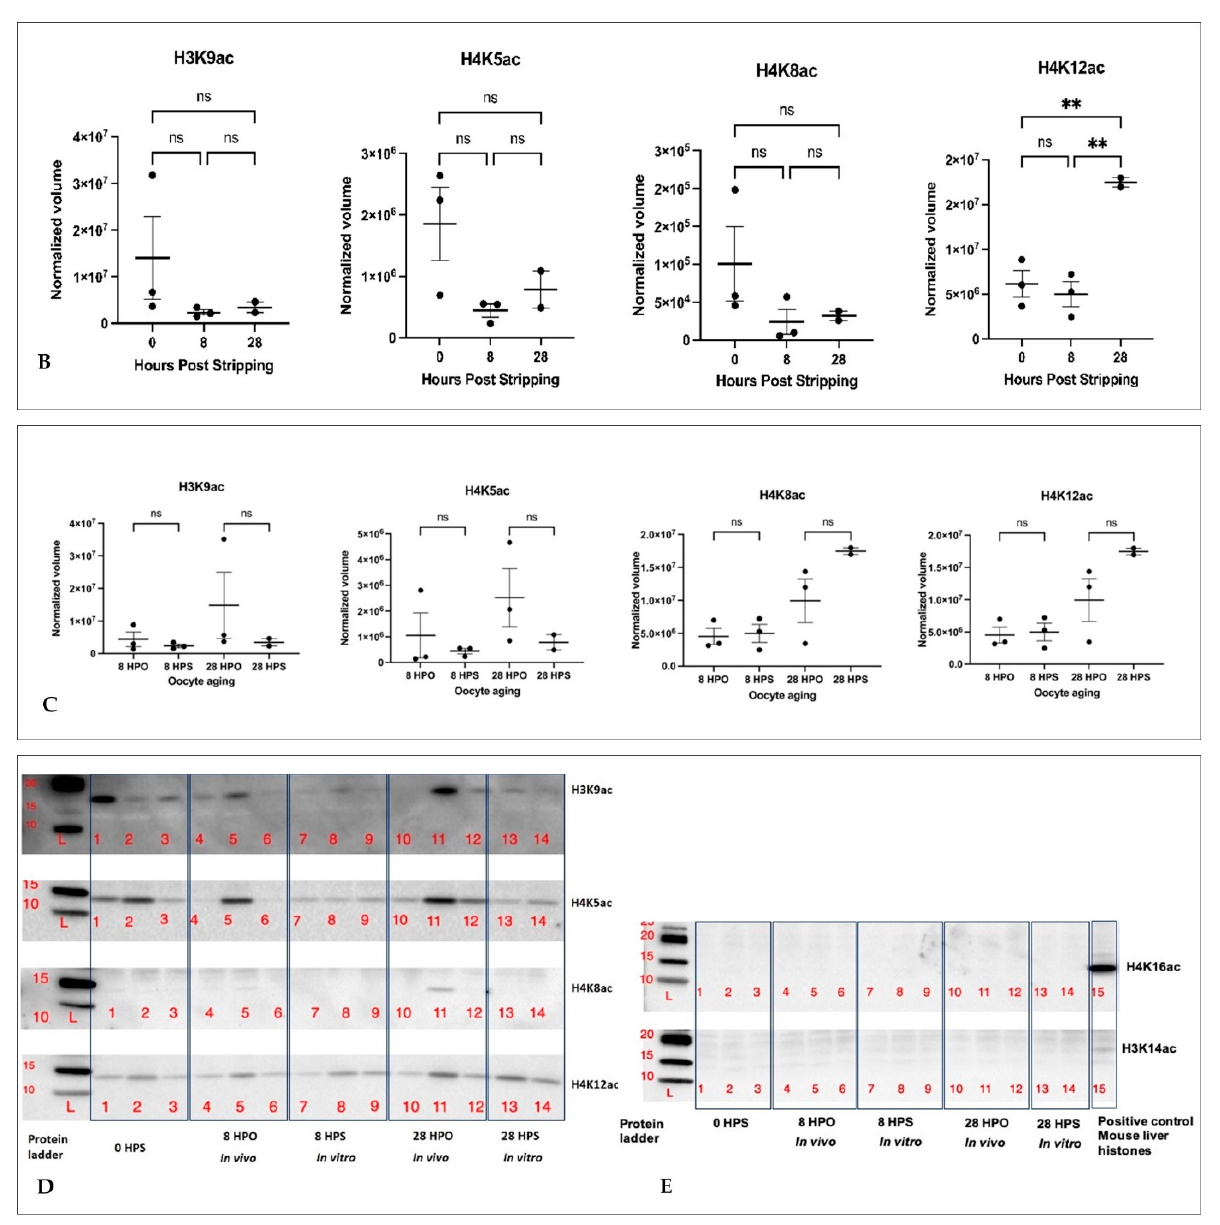
Figure 1. Effect of in vivo ( A ) and in vitro ( B ) oocyte aging on the acetylation of the selected histone lysines in common carp ( p < 0.05, Tukey’s multiple comparisons test; ns: non-significant; ** p < 0.01, mean ± SEM); ( C ) Comparison of histone acetylation at 8 and 28 h between in vivo and in vitro aging conditions. ( D ) Western blot images for H3K9ac, H4K5ac, H4K8ac and H4K12ac; ( E ) Western blot images for H3K16ac and H4K514ac including positive control (mouse liver histones). The numbers in red colour indicate the biological replicates as: fish 1 (1, 4, 7, 10), fish 2 (2, 5, 8, 11, 13), and fish 3 (3, 6, 9, 12, 14).